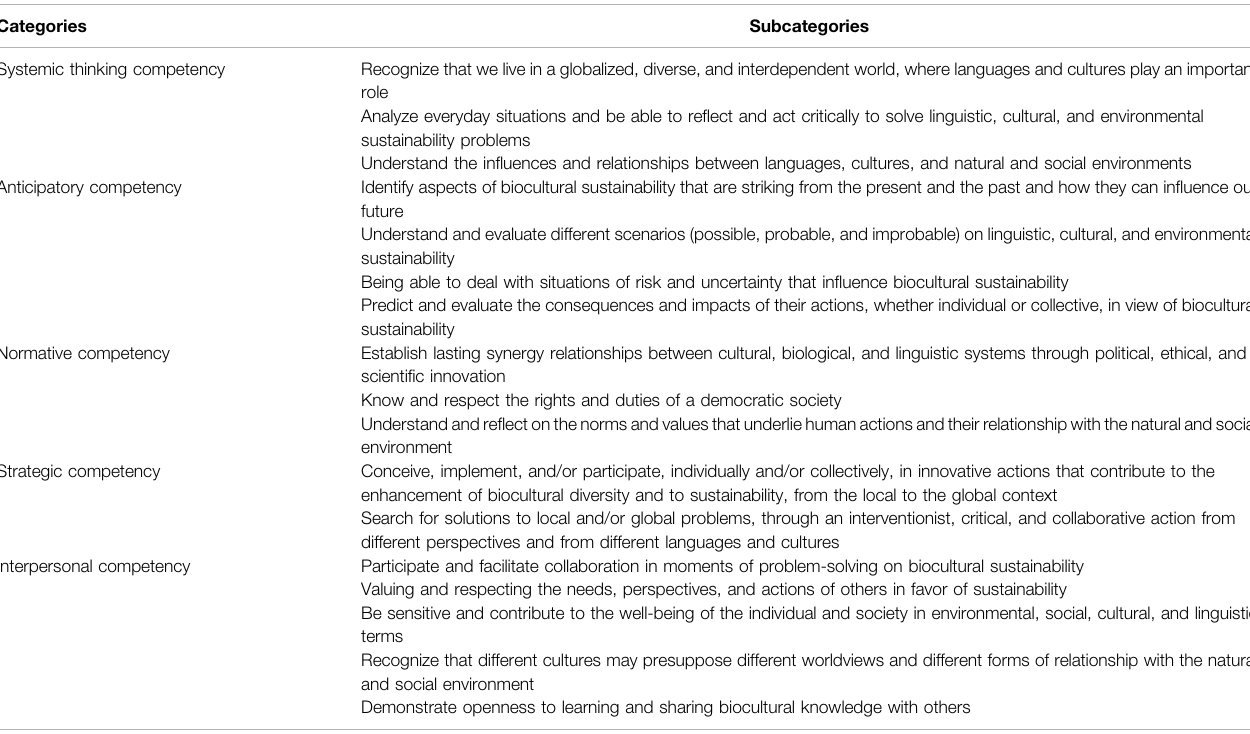
TABLE 3 | Analysis